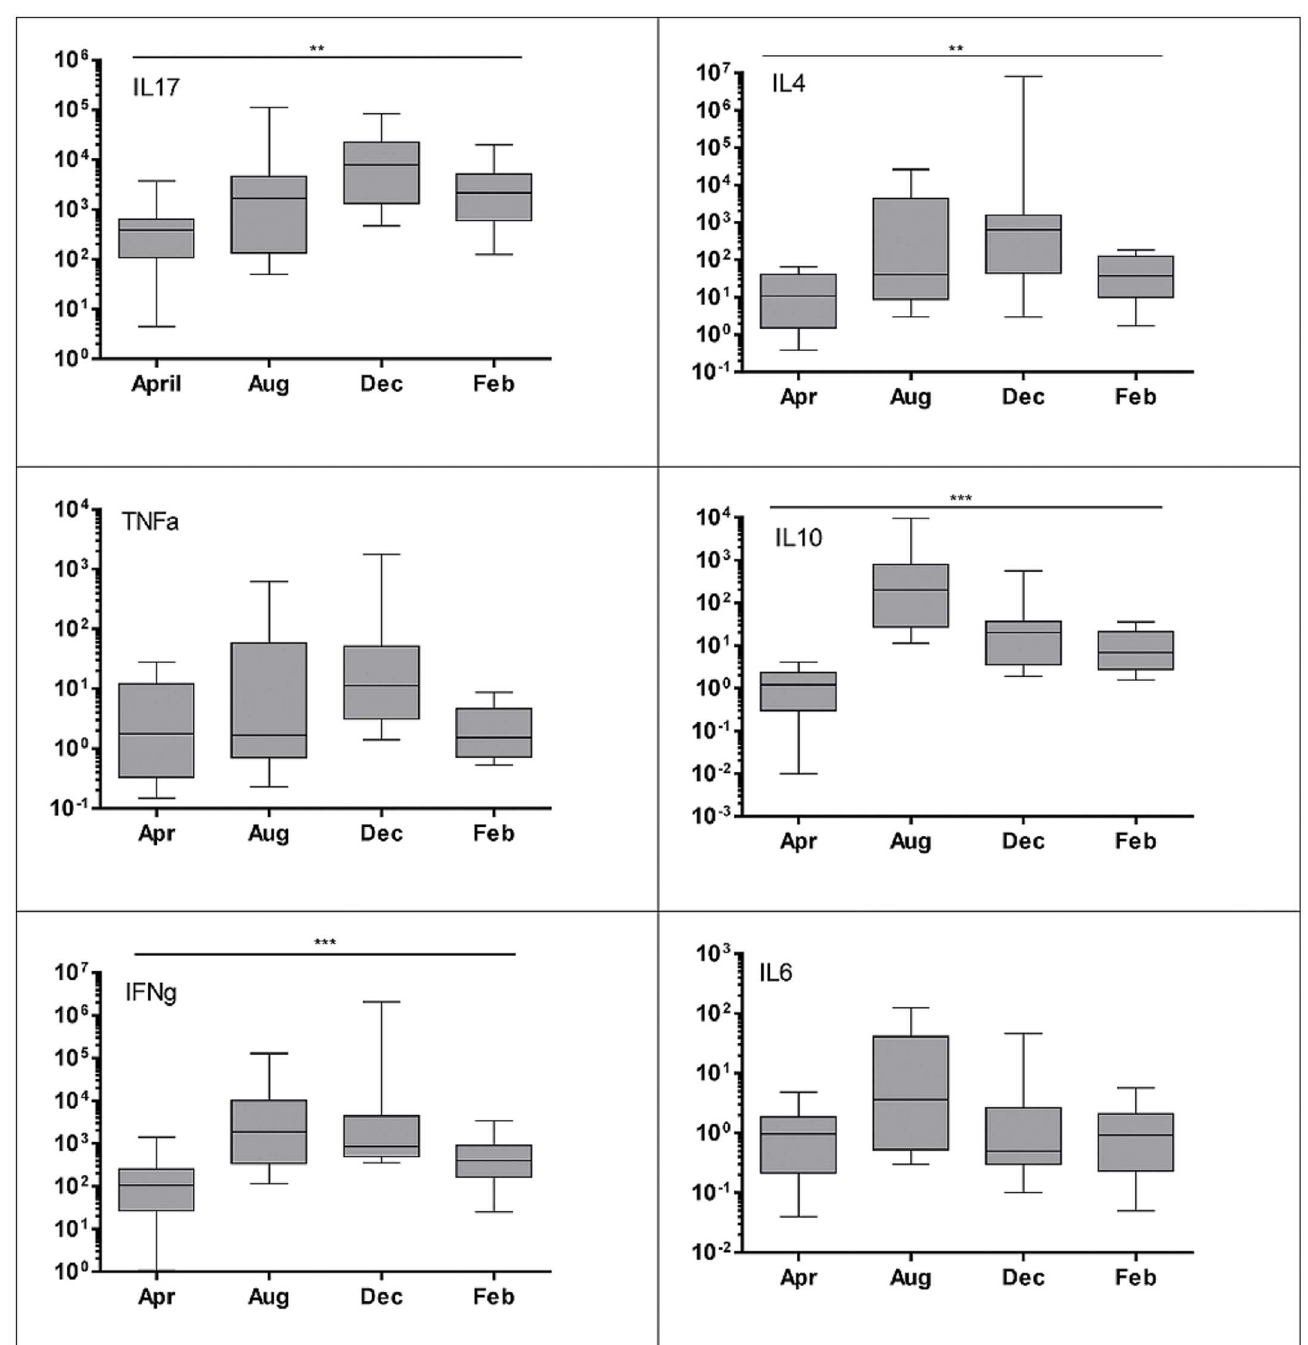
Fig 1. Seasonal difference in cytokine up regulation (PMAio 5h stimulation). * p < 0 . 05 , ** p < 0 . 01 , *** p < 0 . 001 . Kruskal-Wallis one-way ANOVA. Results are expressed as fold change calculatedusing the ΔΔ Cq method [44]. Box represents the 25 th to 75 th percentiles, middle line is median and whiskers are the minimum to maximum